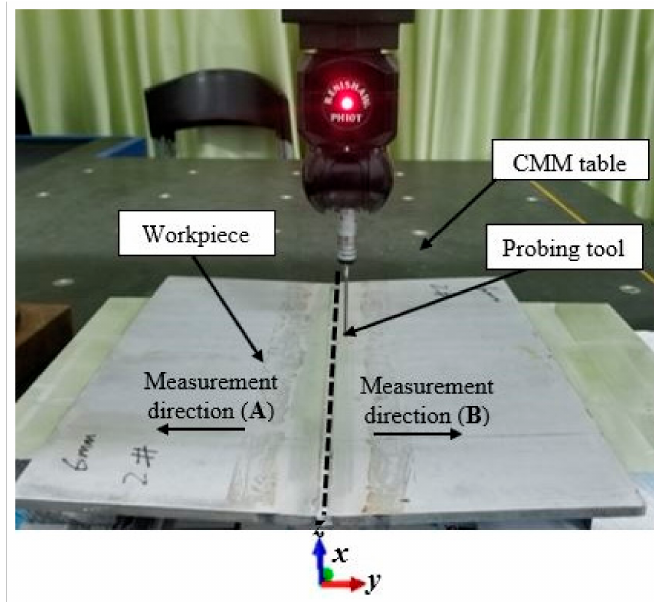
Figure 9. Experimental measurement welding distortion.